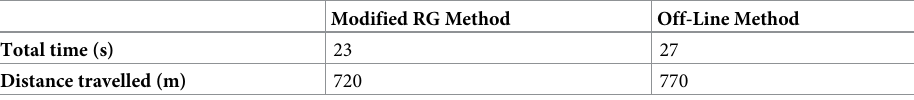
Table 9. Basic overtaking parameters for scenario 3 –a comparison.